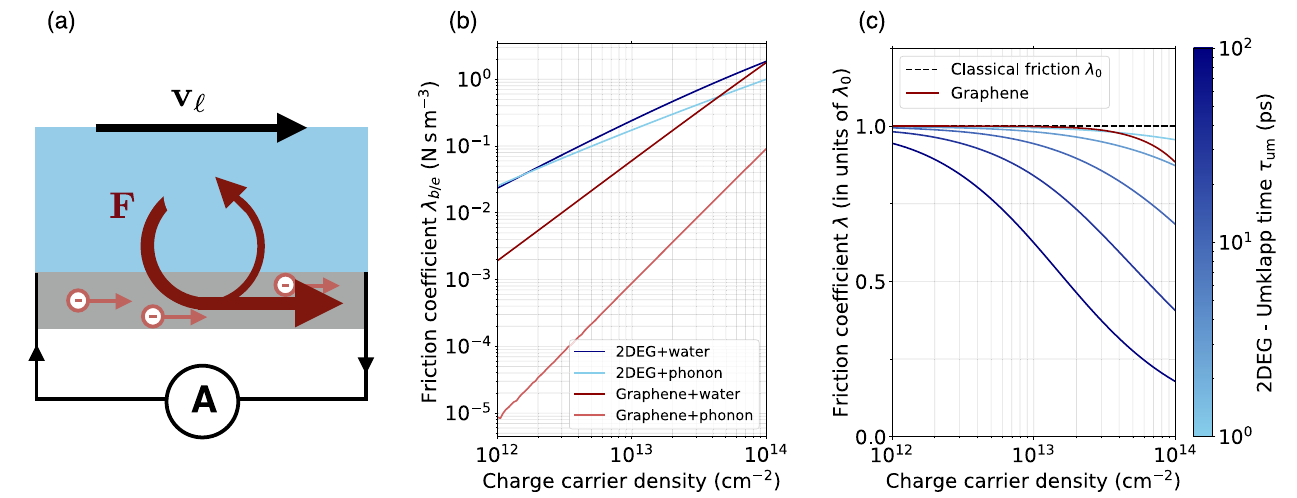
FIG. 7. Quantum feedback and current-induced negative friction. (a) Schematic representation of the quantum feedback phenomenon: a fraction of the momentum transferred to the solid by classical friction is returned to the fluid by the solid ’ s internal excitations. (b) Electron-boson friction coefficients as a function of the electron density for a 2DEG with m ¼ 0 . 1 m according to Eq. (53). The calculations have been carried out using the electronic susceptibilities in the zero-temperature limit and in the RPA approximation. (c) Hydrodynamic friction coefficient λ (in units of the classical contribution λ 0 ) for a 2DEG with m ¼ 0 . 1 m and